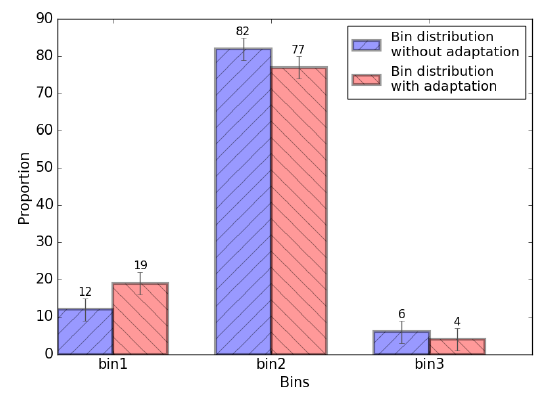
Figure 15. The measured Yield Optimization Rate for b19.